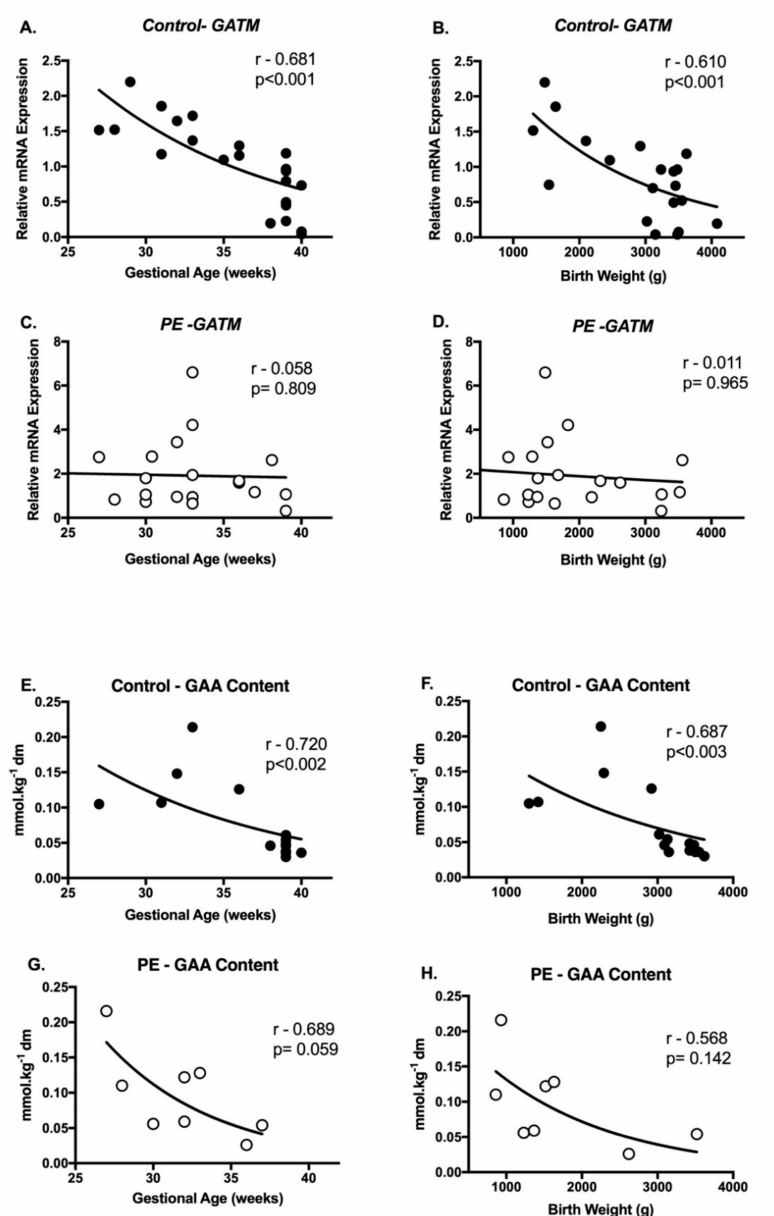
Figure 4. Associations (r) between placental GATM mRNA and gestational age ( A ) and birth weight ( B ) in the control cohort; placental GATM mRNA and gestational age ( C ) and birth weight ( D ) in the PE cohort; placental GAA content and gestational age ( E ) and birth weight ( F ) in the control cohort and GAA content and gestational age ( G ) and birth weight ( H ) in the PE cohort. r values were generated using Spearman’s correlation coe ffi cient. Normotensive placenta data are represented by closed circles and PE placentae open circles. Significance was set at p ≤ 0.004, following a Benjamini-Hochberg adjustment for